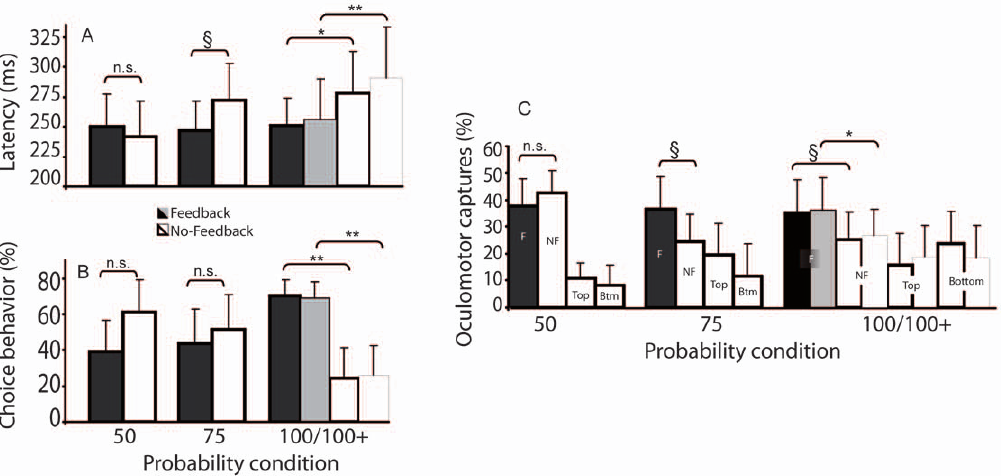
Figure 2. Saccadic performance averaged over all subjects in the 100% feedback probability condition (100 + ) and the subset of subjects who performed all three probability conditions (50%, 75%, 100%). The feedback side is in black (subset) or grey (all subjects), no- feedback side is in white with thick (subset) or thin (all subjects) outlines. Error bars represent SEM. 1 marginal (.051 # p # .13, see text). * p , .05, ** p , .001. A, B. Latency and choice behavior (respectively) as a function of side (feedback; no-feedback) and feedback probability. C. Oculomotor captures as a function of side (F, feedback; NF, no-feedback; Top; Bottom) and feedback probability.